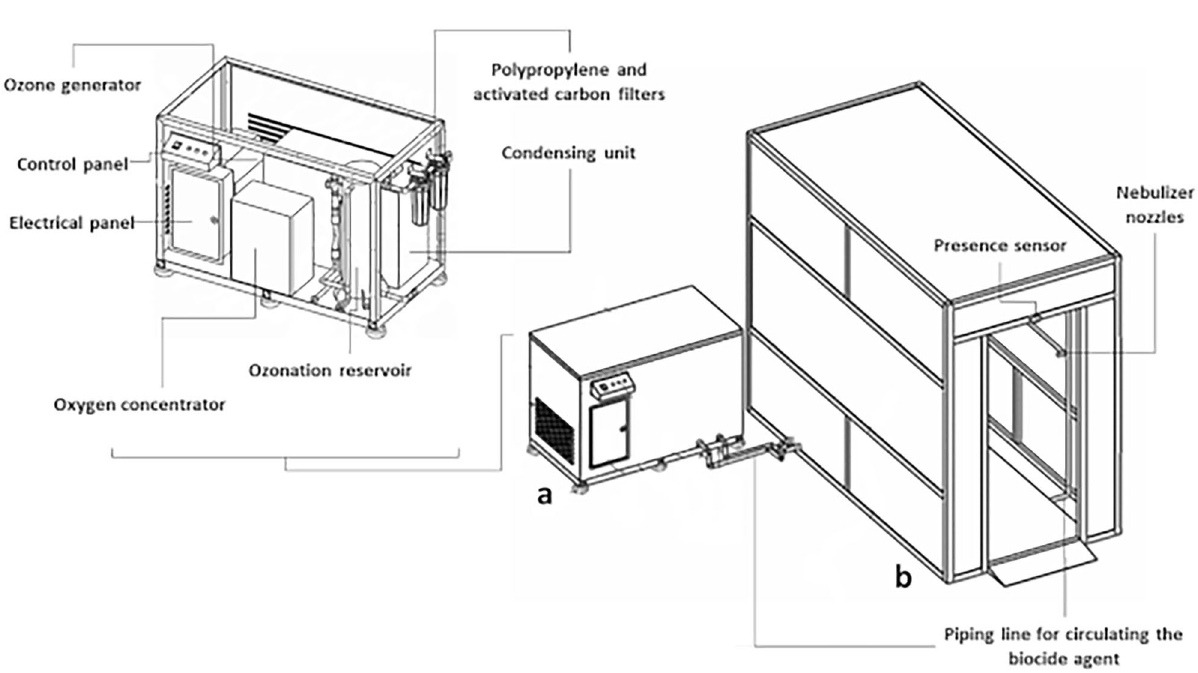
Figure 2. Disinfection technology consisting of ( a ) ozonation unit and ( b ) ozonated water spray disinfection